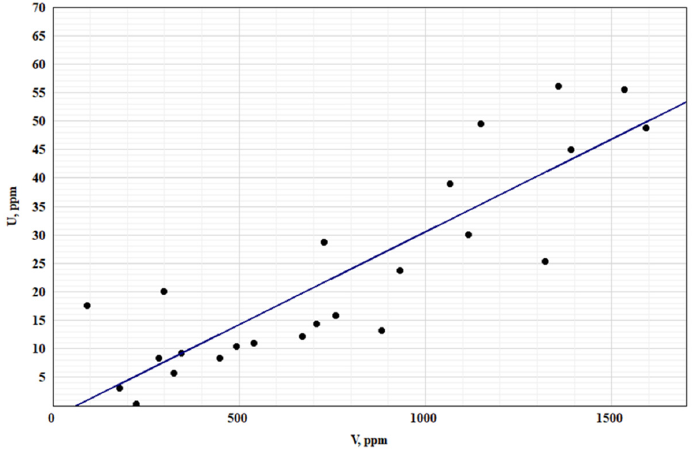
Figure 4. Cross ‐ plot of uranium and vanadium concentrations for well 1, Bazhenov Formation. Blue